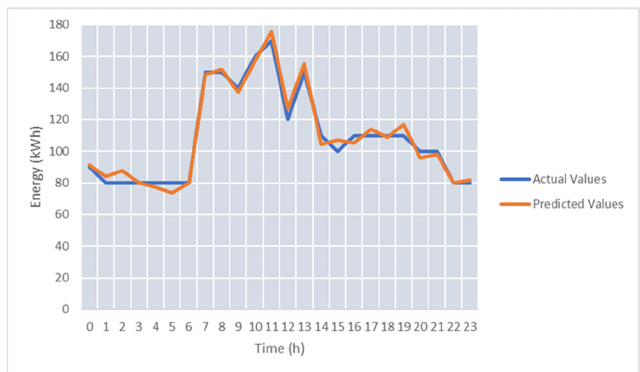
Figure 16. TC-M3: best predicted day (SMAPE = 3.38%).